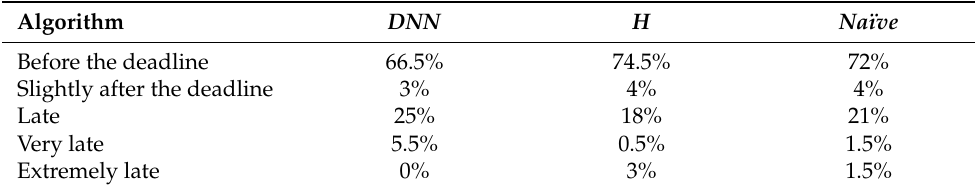
Table 6. Lateness distribution for the three